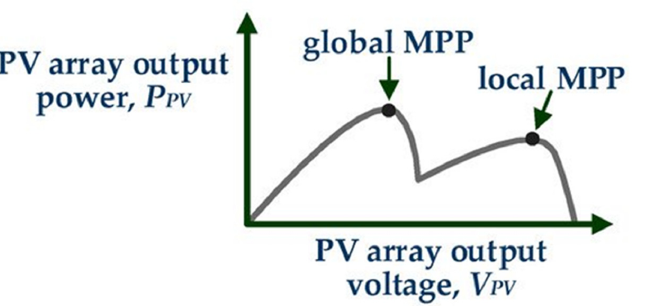
Figure 2. An example of the power-voltage characteristic of a photovoltaic (PV) array under partial shading conditions [77].